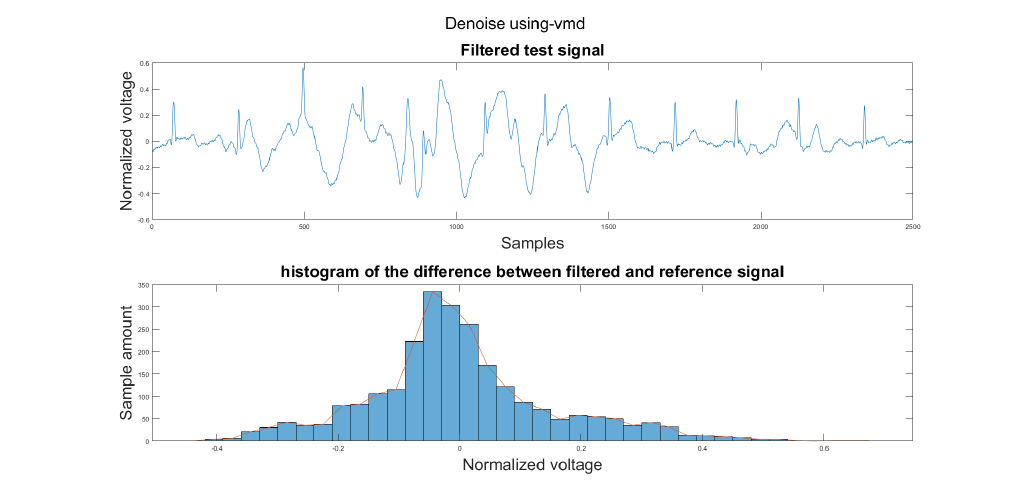
Figure A12. (1) Test signal, (2) histogram of the difference.